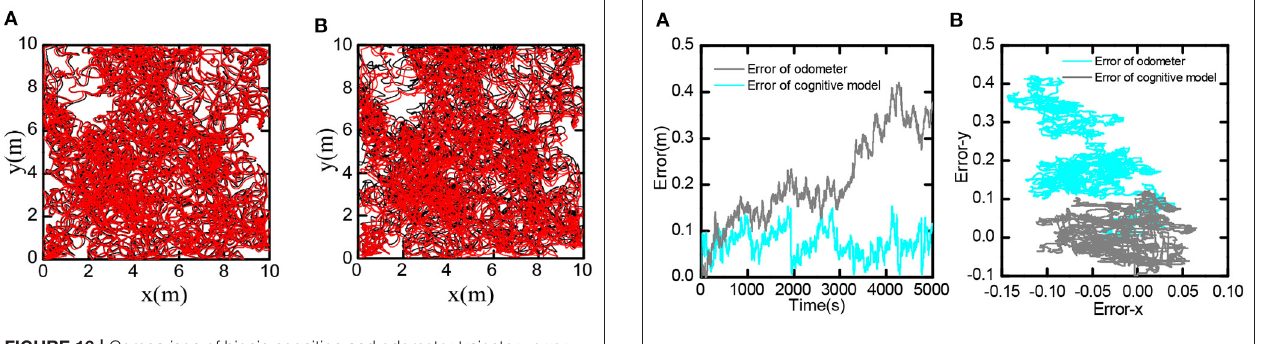
FIGURE 17 | Bionic spatial cognitive model and odometer error comparison, (A) Comparison of error value from 0 to 5,000s. (B) Comparison of the distribution of error values in the entire